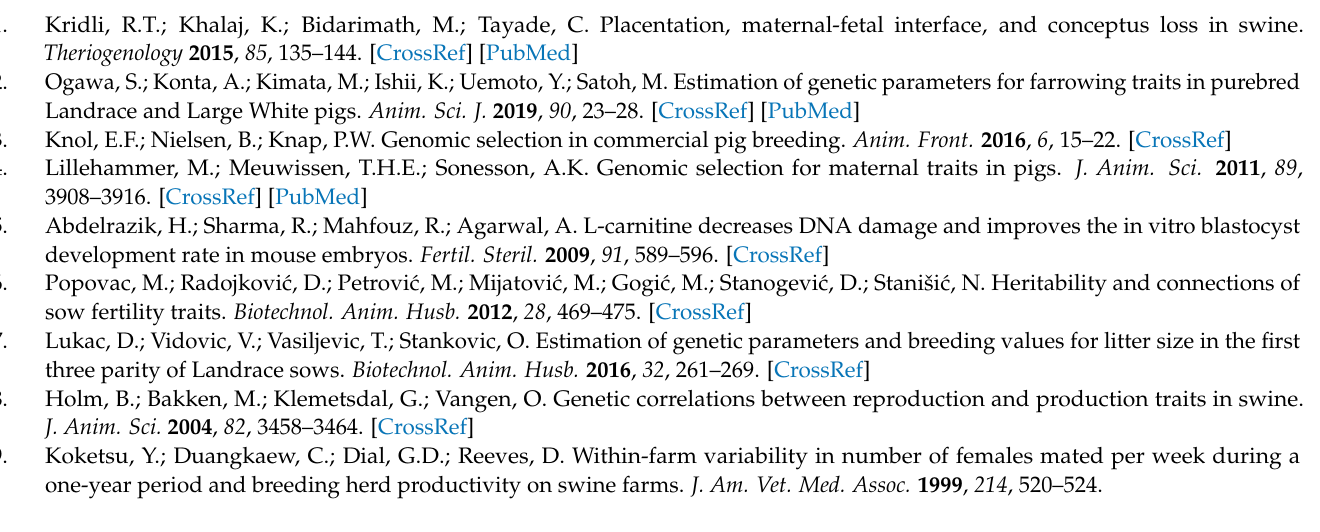
Table S6: Serum metabolites found at significantly different ( p < 0.05) concentrations between HRP and INF